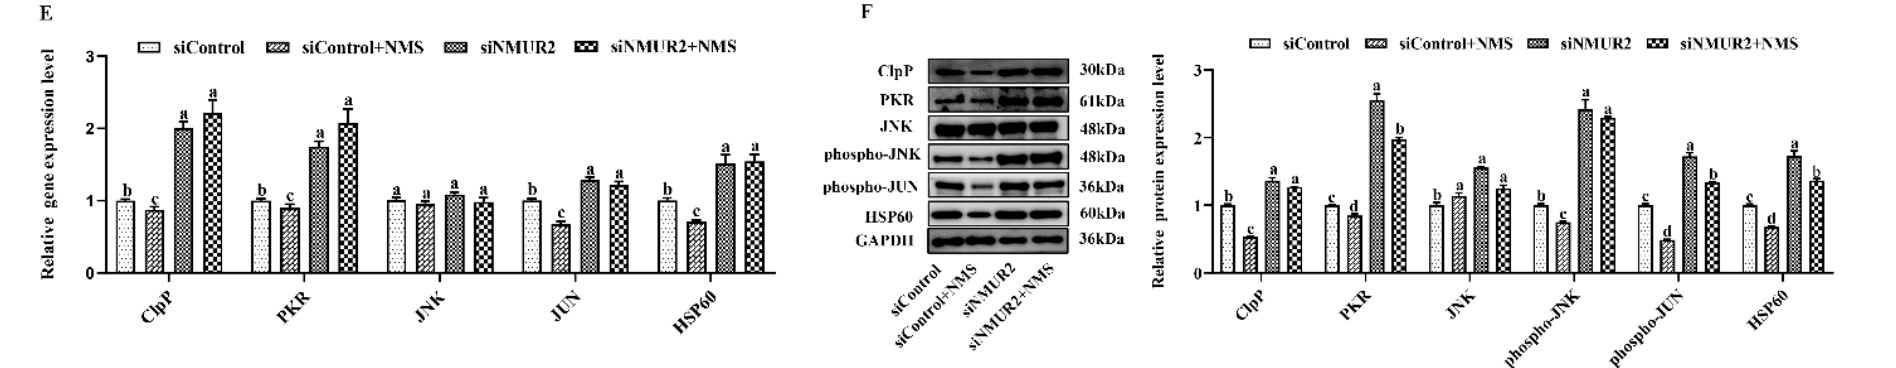
Figure 5. NMS regulates mitochondrial function via mitochondrial unfolded protein response in goat granulosa cells. ( A ) Representative images (left) and statistical quantification (right) of the mitochondrial membrane potential results. The goat GCs were stained with JC-1 under NMS with or without siNMUR2 treatment. ( B ) Representative images ( left ) and statistical quantification ( right ) of ROS production assay results. The goat GCs were stained with DCFH-DA under NMS with or without siNMUR2 treatment and observed under a fluorescence microscope. DCFH-DA: green; Hoechst 33342: blue. ( C ) MRC activities in goat GCs under NMS with or without siNMUR2 treatment are expressed as nmoles/min/mg of protein. CS, citrate synthase; CI–IV, MRC complexes I–IV. ( D ) Intracellular ATP level after one hour in goat GCs under NMS with or without siNMUR2 treatment. ( E ) The mRNA expression of genes related to mitochondrial unfolded protein response marker genes was determined by qPCR. ( F ) The protein expression of genes related to mitochondrial unfolded protein response marker proteins was determined by Western blot. Data are representative of at least three independent experiments. Different letters indicate significant differences in the expressions between the groups ( p < 0.05).